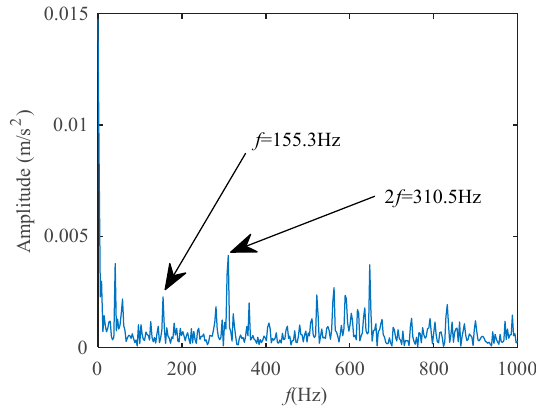
Figure 17. CCES of the signal at the fan end.